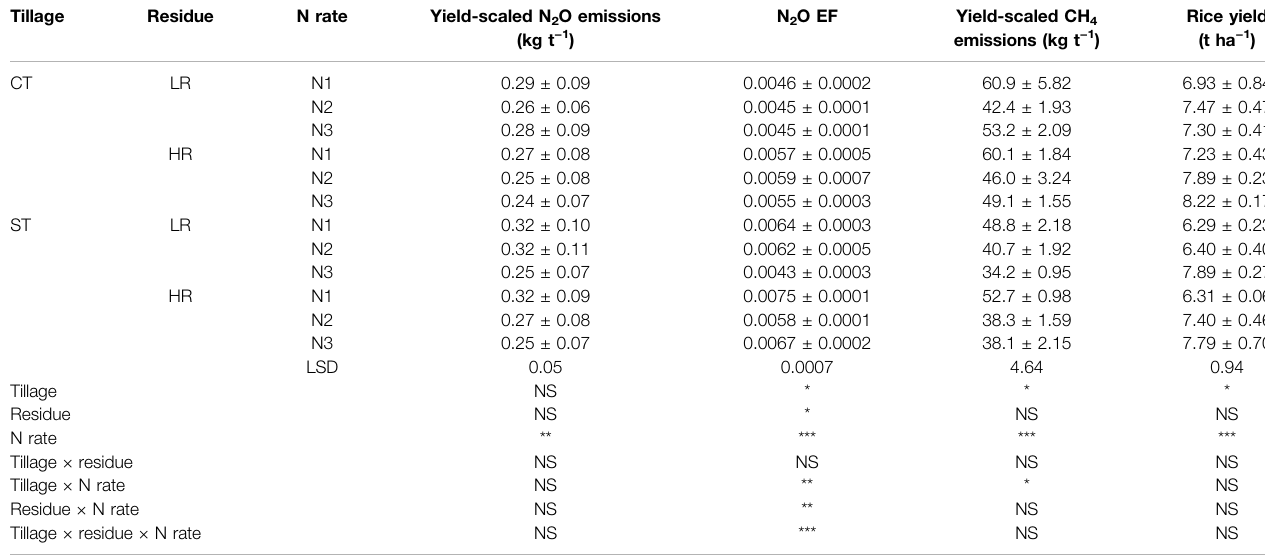
TABLE 2| Effect of tillage systems (conventional tillage, CTand strip tillage, ST), residue levels (low residue, LR and high residue HR), and Napplication rates(108, 144, and 180 kg ha − 1 ) on Boro rice yield, yield-scaled CH 4, and N 2 O emissions, and N 2 O emission factor ( n = 3; mean ± SE). Tillage